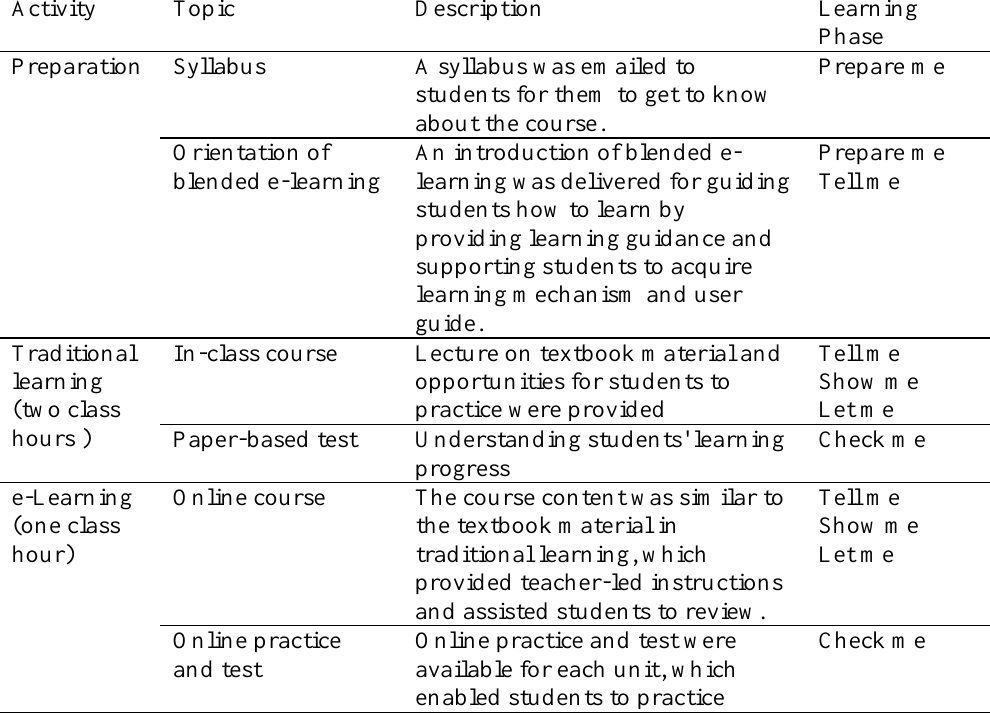
Learning Activity for Blended